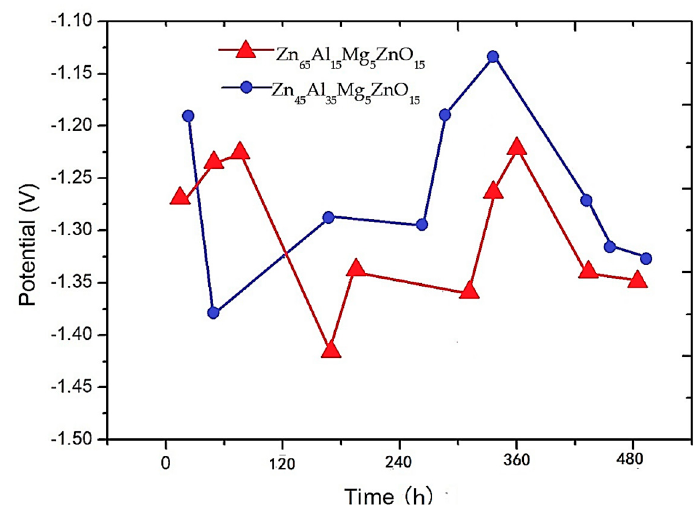
Figure 6. Open circuit potentials of Zn 65 Al 15 Mg 5 ZnO 15 and Zn 45 Al 35 Mg 5 ZnO 15 at different times.